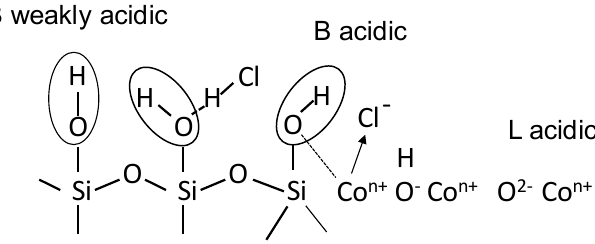
Figure S1: N 2 adsorption-desorption isotherms of the 30Co/SBA catalyst and the pure SBA-15 support and pore size distribution, Figure S2. XRD pattern of the 30Co/SBA catalyst. Table S1: Textural properties of the SBA-15 support and the 30Co/SBA support and the 30Co/SBA catalyst